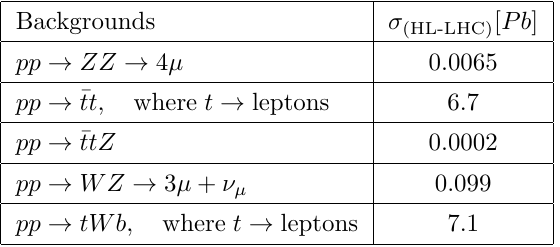
Table 2 . Dominant background processes considered in our analysis and their total cross